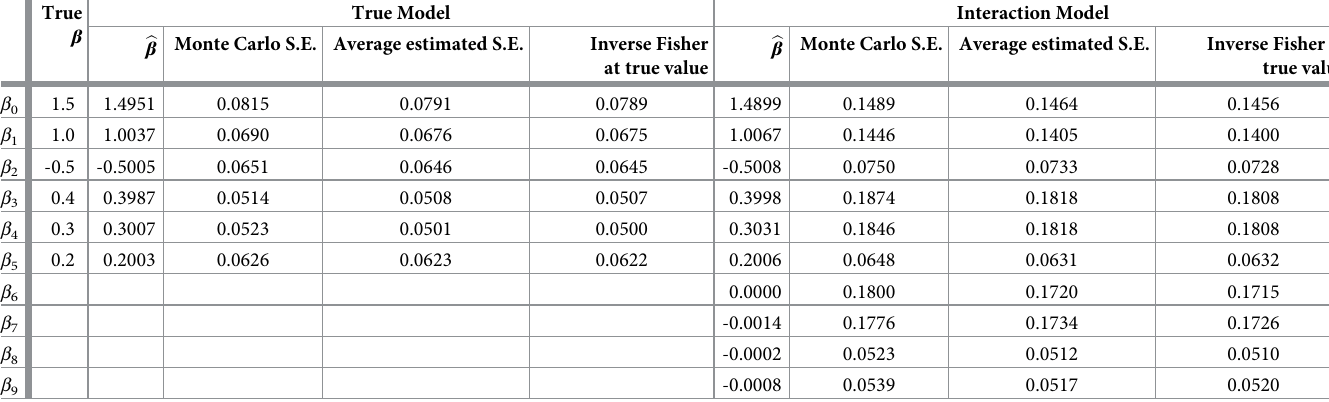
Table 1. Simulation results. True coefficients, estimated parameters, Monte Carlo standard error, inverse Fisher information matrix evaluated at estimated parameters and inverse Fisher information matrix at the true value. All parameters are calculated based on 1000 Monte Carlo replicates with sample size equals to 400. True True Model Interaction Model β b β Monte Carlo S.E. Average estimated